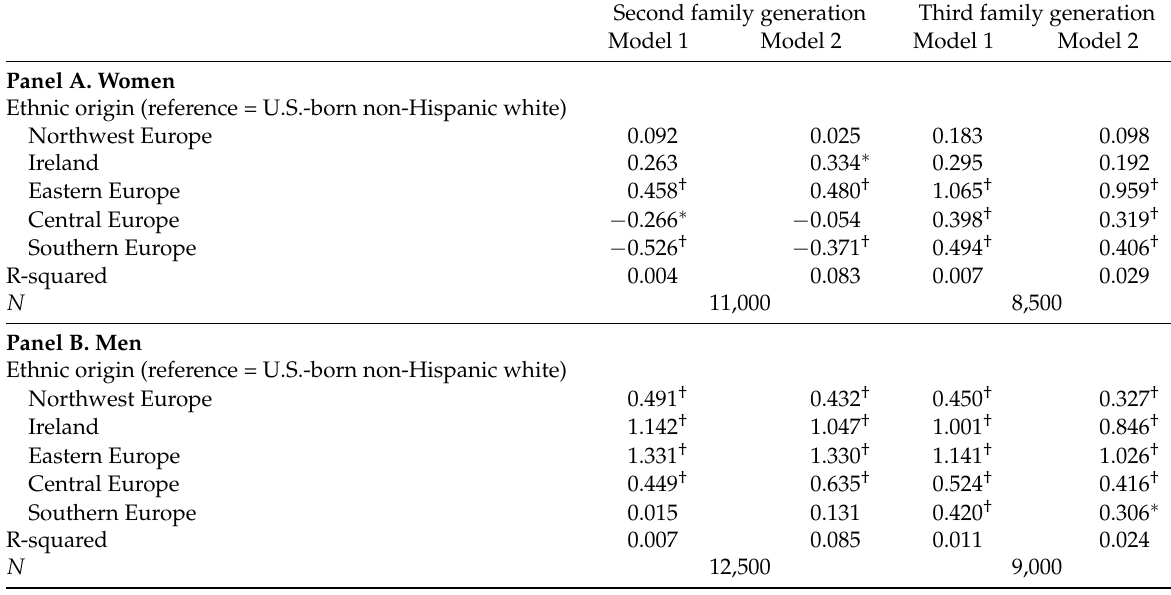
Table 2: Educational attainment by ethnic origin among second and third family generation women and men (ordinary least squares regression models)